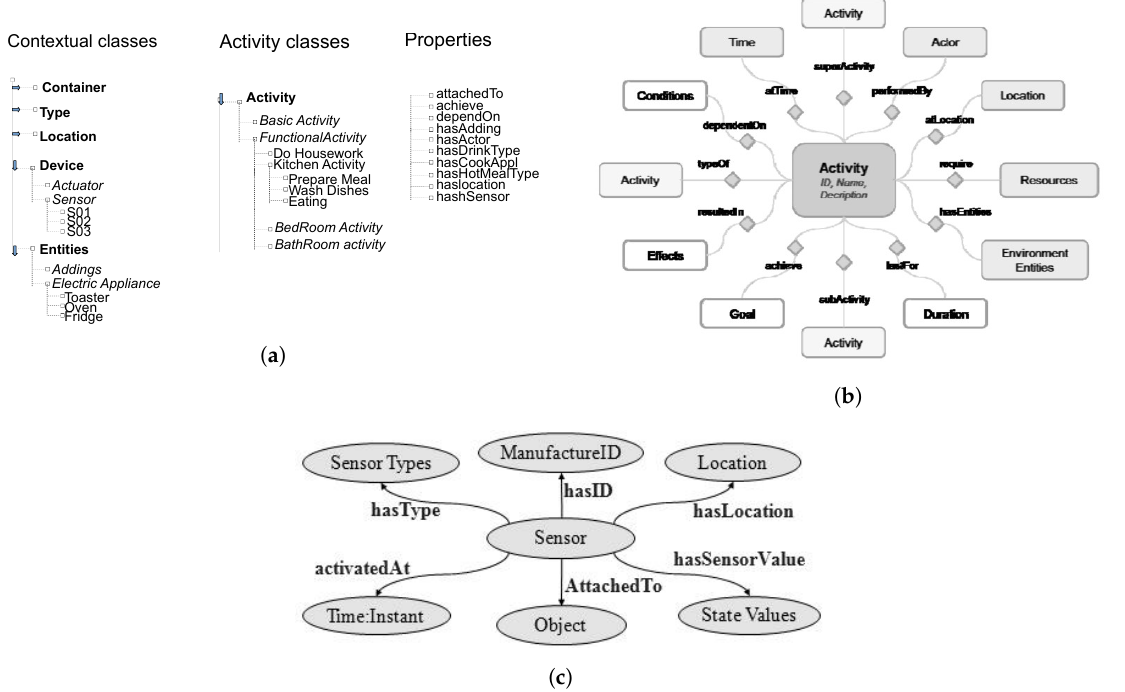
Figure 7. Ontologies used in CHEN - ONT [18] to model the aspects of smart spaces. ( a ) Ontology example used to model the Smart Environment domain. Picture inspired to CHEN - ONT [18]. ( b ) Ontology example used to model the activities correlations. Picture taken from CHEN - ONT [18]. ( c ) Ontology example used to model the sensors properties. Picture taken from CHEN - ONT